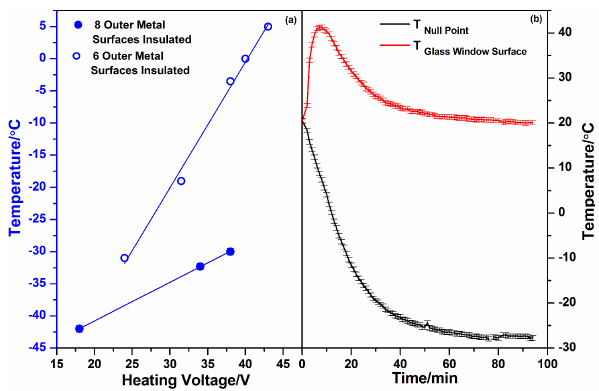
Figure 3. Temperature characterisation curves for the null-point re- gion of the CEDB. Two different insulation schemes allow access to different temperature ranges in the EDB. (a) Final temperature reached when eight outer metal surfaces (blue solid circles) or six outer metal surfaces are insulated (blue circles) CEDB chamber ver- sus heating voltage. (b) An example of glass window surface (red line) and null-point (black line) temperature reaching − 28 ◦ C with 24V heating